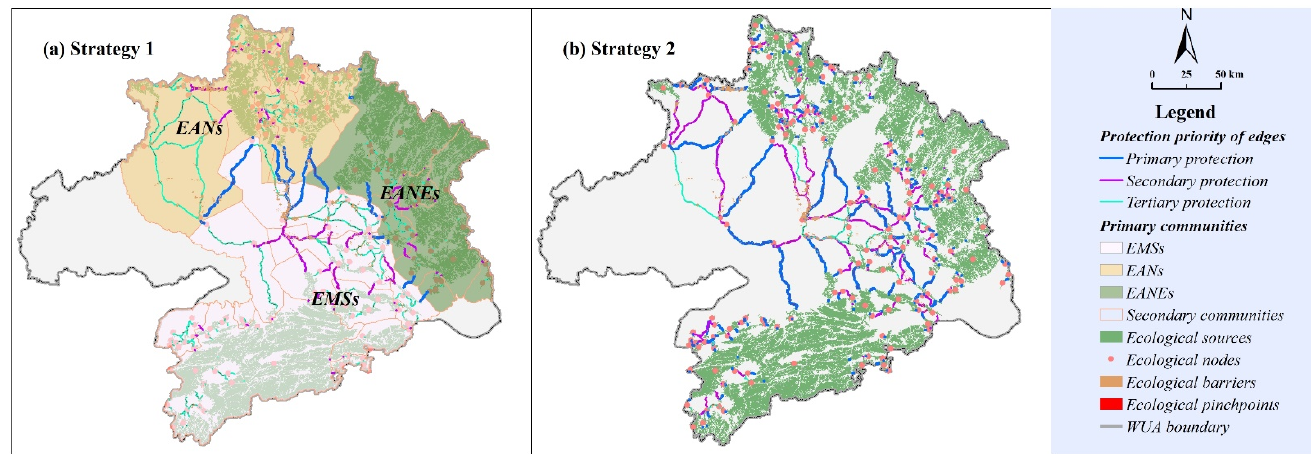
Figure 14. Protection strategies of ecological corridors in WUA.